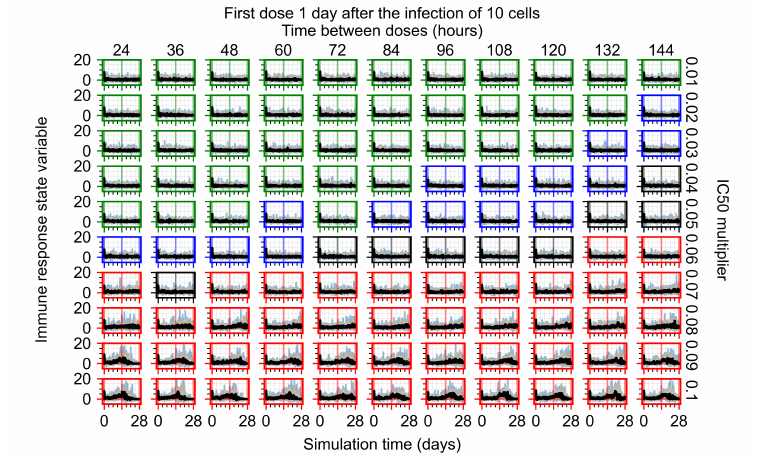
Figure A29. Immune response state variable number. Positive values correspond to an inflammatory state, and negative to an anti-inflammatory state.